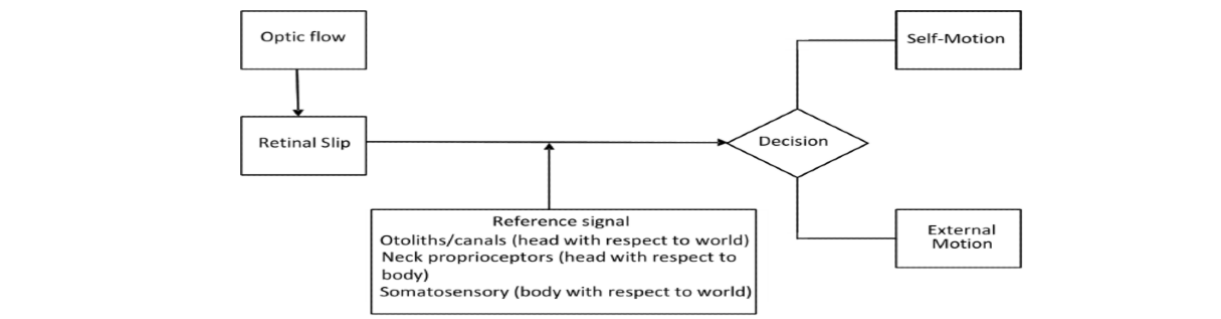
Figure 1. The sources of information to allow differentiation of self-motion and object motion components. The various sources are shown as giving information with respect to different reference